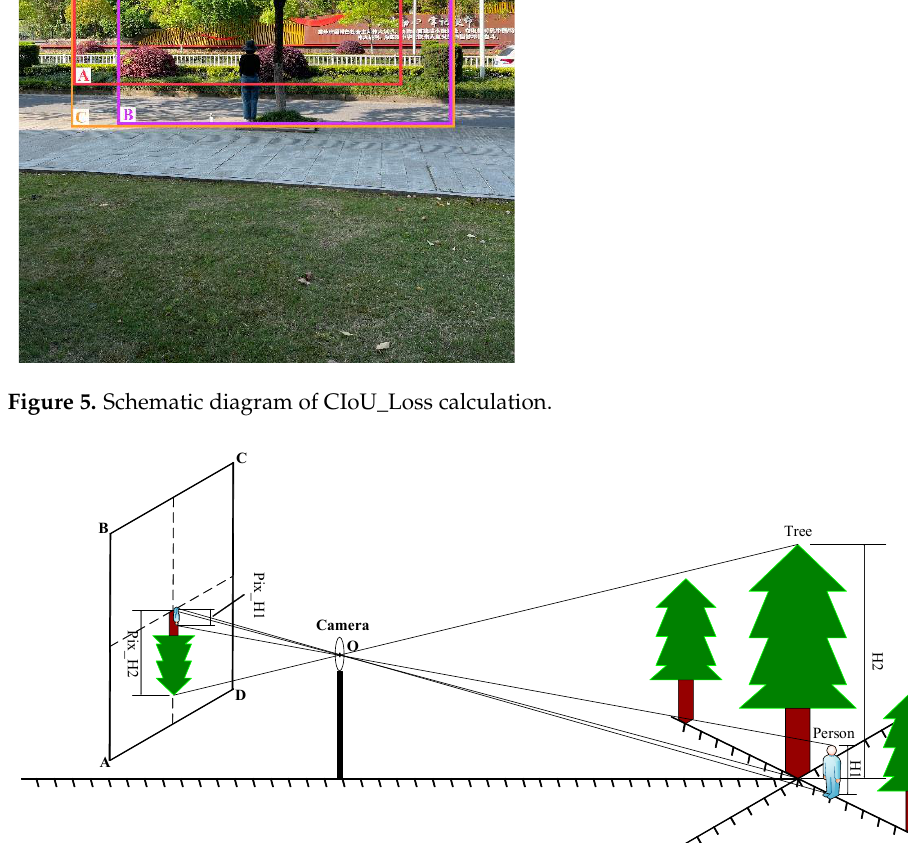
Figure 7. Flow chart for extracting the height of urban forest trees based on a smartphone with the person–tree scale height measurement model. 2.2.2. Training of the Person–Tree Scale Height Measurement Model The images in the constructed training set were labeled, and then the training of the person–tree scale height measurement model was performed. The hardware environment for the experiments was as follows. The CPU configuration was an Intel(R) Xeon(R) Gold 6154 CPU @ 3.00 GHz, the graphics card configuration was an NVIDIA RTX A6000, the video memory size was 47.5 GB, and the memory size was 64 GB. The software environ- ment for the experiments was as follows. The operating system was Windows 10, the CUDA version was 11.1, the Python version was 3.9.7, and the PyTorch version was 1.8.1. In this study, the model was trained based on Ultralytics LLC YOLOv5, and the small-hole imaging and scale principles were innovatively incorporated into the model. To prevent gradient explosion, the initial learning rate of the weights was set to 0.01, and the learning rate was dynamically reduced by using the cosine function. The momentum factor was set to 0.937, and the pretrained model was YOLOv5x.pt. The number of training